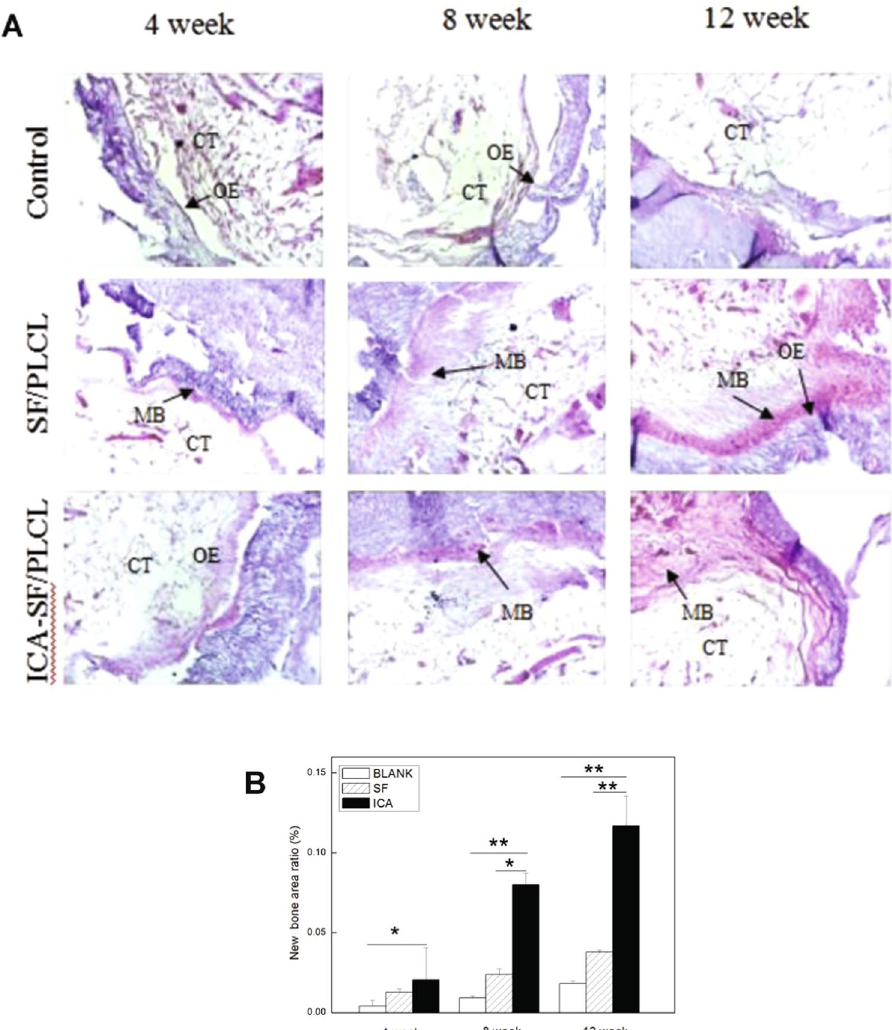
Figure 8. Histological analysis of bone formation in calvarial defects. ( A ) Hematoxylin and eosin staining images of calvarial defects. Scale bar = 0.2 mm. ( B ) Quantification of percentage of new bone area in calvarial defects. * Significantly more bone formation compared with control ( * p < 0.05, ** p < 0.01). (CT indicates connective tissue; MB indicates mineralized bone matrix; OE indicates osteoectomy edge. SF indicates SF/PLCL membrane group; ICA indicates ICA-SF/PLCL nanofibrous membrane